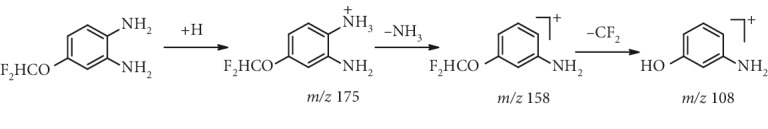
Typical MRM chromatograms of a mixed solution of impurities C–H and DMBZ (100 ng/mL).